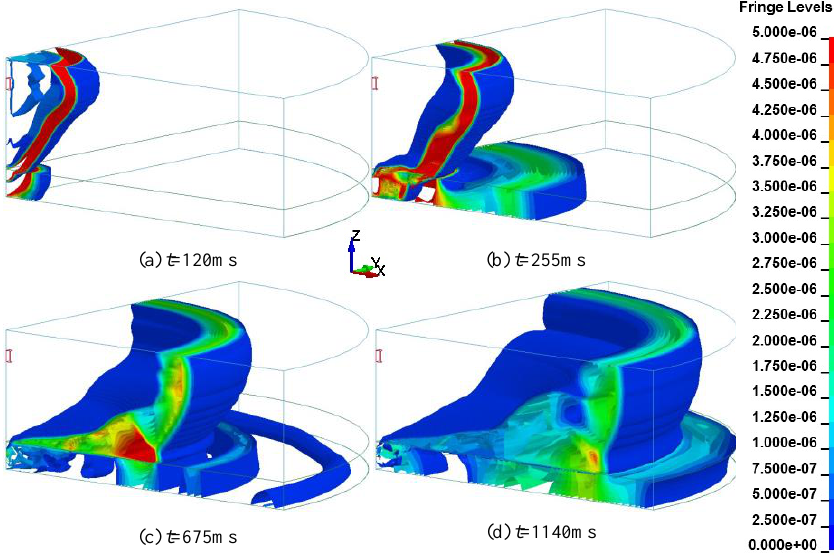
Figure 6. Pressure contours images of the shock wave above the concrete ground.